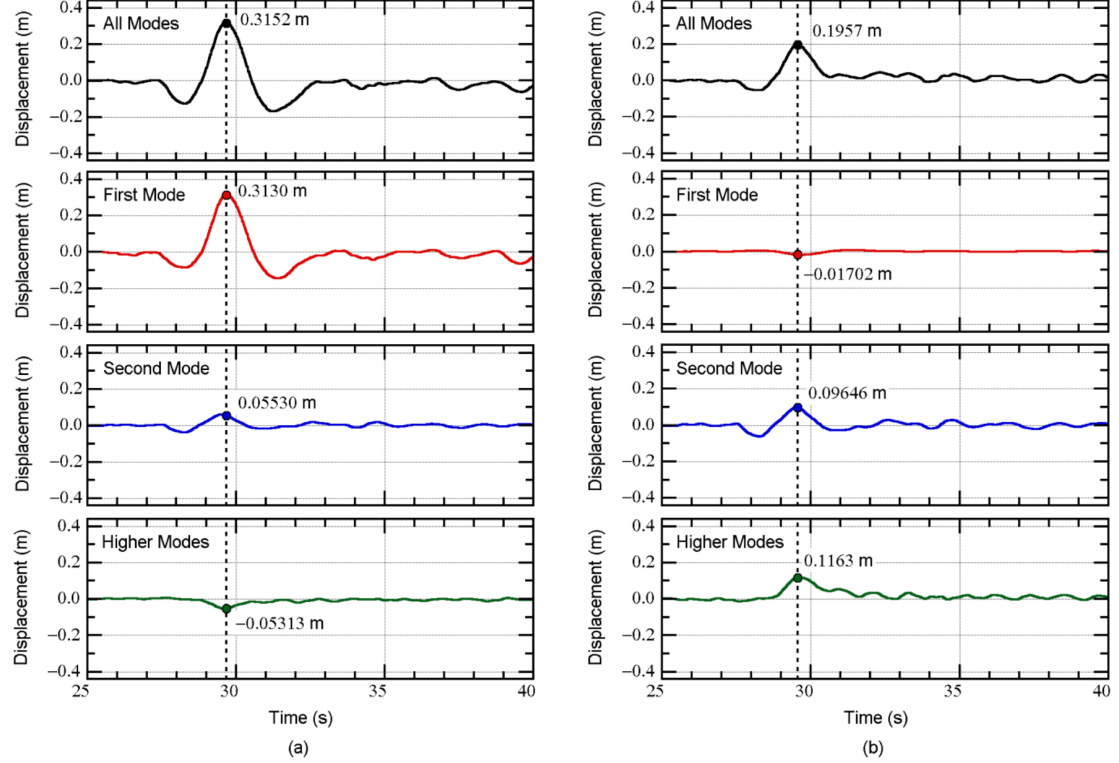
Figure 42. Comparisons of the modal responses at the edge of level 0 (structural model: Model-Tf34, ground motion: TCU, angle of incidence of seismic input: ψ = 60 ◦ ): ( a ) X 1A and ( b ) X 6A .